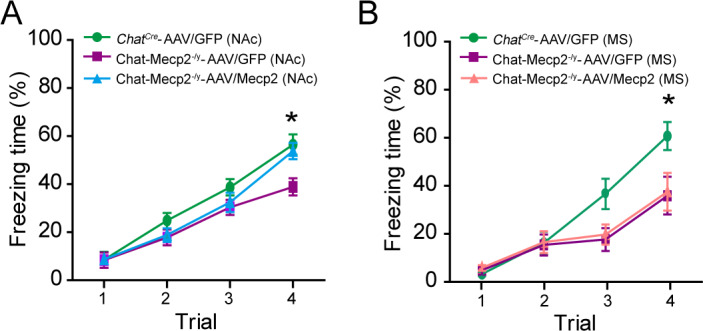
Restoration of MeCP2 in NAc rather than Cholinergic neurons of MS Rescued Fear deficit at the last trial of learning, Related to Figure 2.(A, B) Fear conditioning test was conducted three weeks after microinjection in NAc (A) or MS (B). P-values were calculated by one-way analysis of variance (ANOVA) with Bonferroni’s multiple comparisons test. F (2, 27)=5.929, p=0.0073 for Trial four during fear learning in (A). Bonferroni’s multiple comparisons test: P (ChatCre-AAV/GFP in NAc vs. Chat-Mecp2-/y-AAV/GFP in NAc)=0.0060, P (Chat-Mecp2-/y-AAV/GFP in NAc vs. Chat-Mecp2-/y-AAV/Mecp2 in NAc)=0.0241. F (2, 31)=4.258, p=0.0232 for Trial four during fear learning in (B). Bonferroni’s multiple comparisons test: P (ChatCre-AAV/GFP in MS vs. Chat-Mecp2-/y-AAV/GFP in MS)=0.0461, P (Chat-Mecp2-/y-AAV/GFP in MS vs. Chat-Mecp2-/y-AAV/Mecp2 in MS)>0.9999. n = 11 (ChatCre-AAV/GFP in NAc), 9 (Chat-Mecp2-/y-AAV/GFP in NAc), 10 (Chat-Mecp2-/y-AAV/Mecp2 in NAc); 15 (ChatCre-AAV/GFP in MS), 8 (Chat-Mecp2-/y-AAV/GFP in MS), 11 (Chat-Mecp2-/y-AAV/Mecp2 in MS). Data are means ± SEM. *p<0.05, NS means no significance.